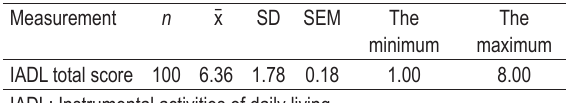
TABLE 2. Average value of IADL in the total sample Measurement n x ̄ SD SEM The